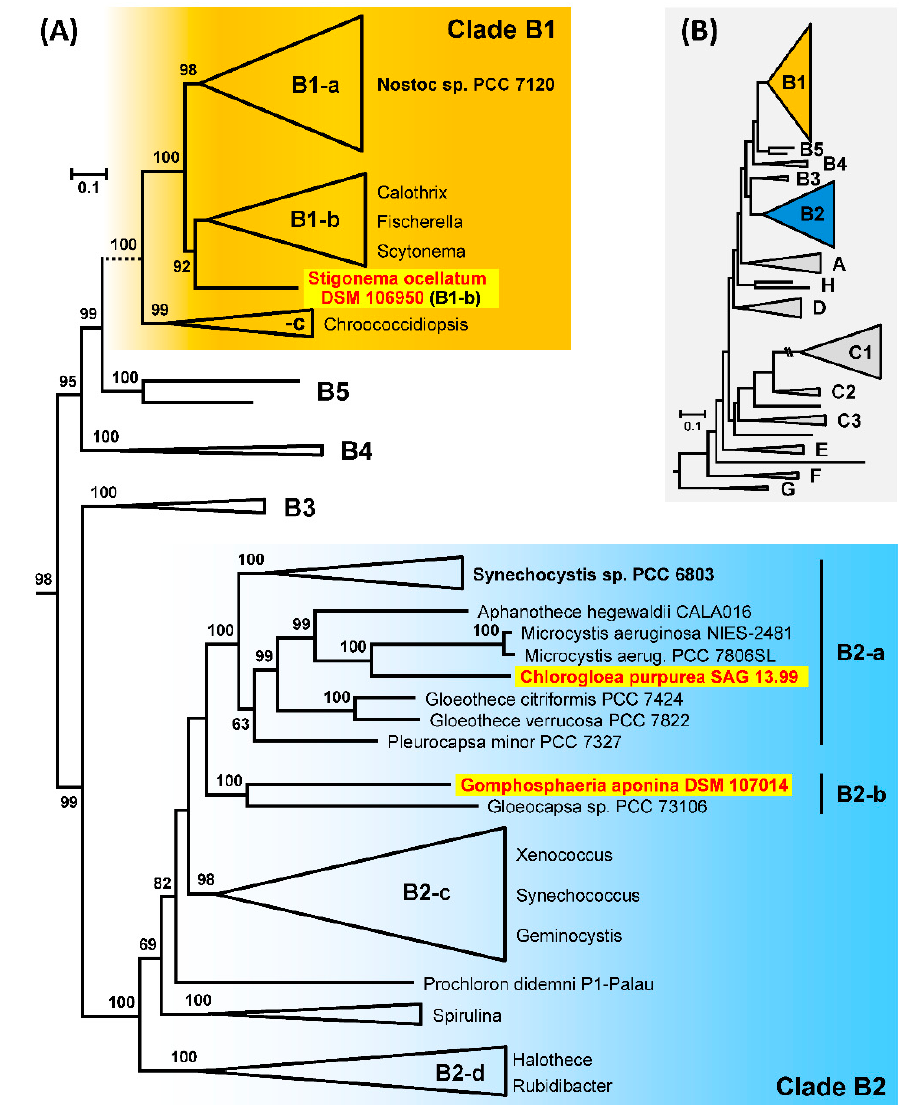
Figure 5. Phylogenetic maximum likelihood tree of 213 genome-sequenced cyanobacteria. ( A ) The MLSA phylogeny was inferred by RAxML under the GTR + 4 Γ model based on a concatenated alignment of 43 proteins with 6458 amino acid positions. Bootstrap support of 100 replicates is indicated. The branching pattern of clade B1 corresponds to a subanalysis of 70 strains (Figure S3). Three cyanobacteria investigated in the current study are highlighted in red with a yellow background. ( B ) Schematic overview of the cyanobacterial diversity (see MLSA tree of 213 taxa; Figure S2). The cyanobacterial clades were designated according to Shih et al. (2013). Their division in different subclades (e.g., B1-a, -b, -c) is based on the current analysis.